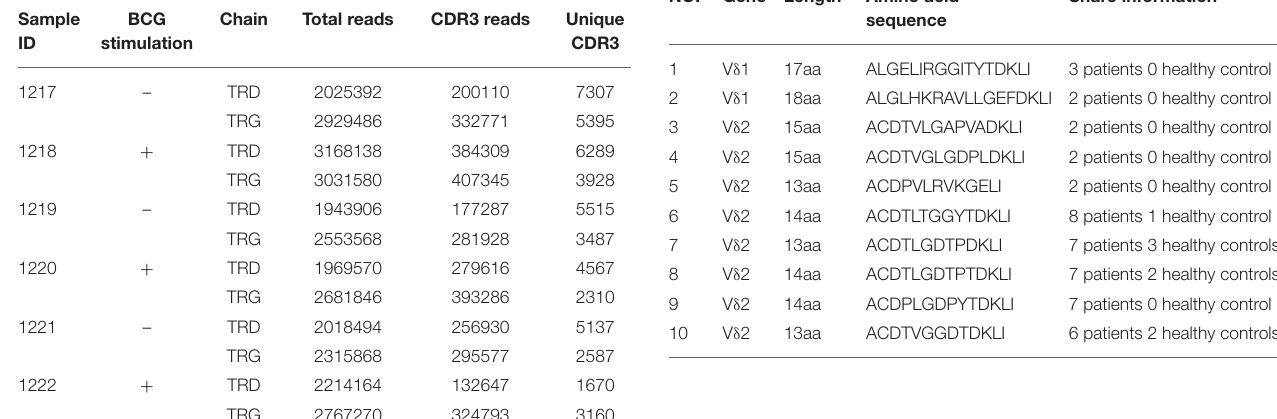
FIGURE 3 | TRDV2 , TRDV3 ), D fragments ( TRDD1 , TRDD2 , TRDD3 ), and J fragments ( TRDJ1 , TRDJ2 , TRDJ3 , TRDJ4 ). (K) The germline gene usage of T-cell receptor γ -chain (TRG) V fragments ( TRGV2 , TRGV3 , TRGV4 , TRGV5 , TRGV8 , TRGV9 ) and J fragments ( TRGJ1 , TRGJ2 , TRGJP , TRGJP1 , TRGJP2 ). Data represent